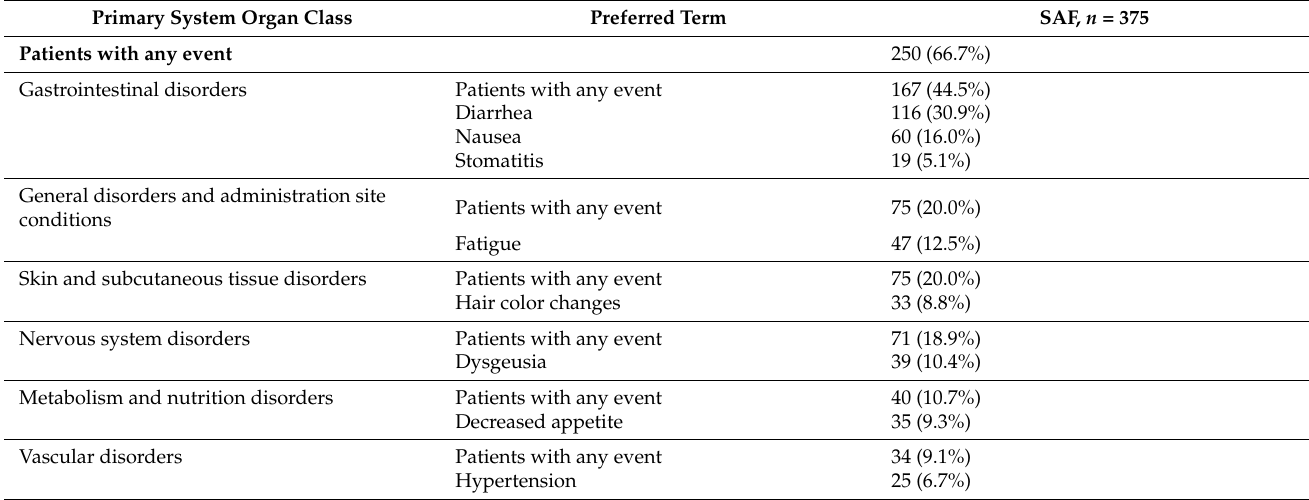
Table 3. Related TEAE of CTCAE severity grade 1/2 under first-line pazopanib with an occurrence of at least